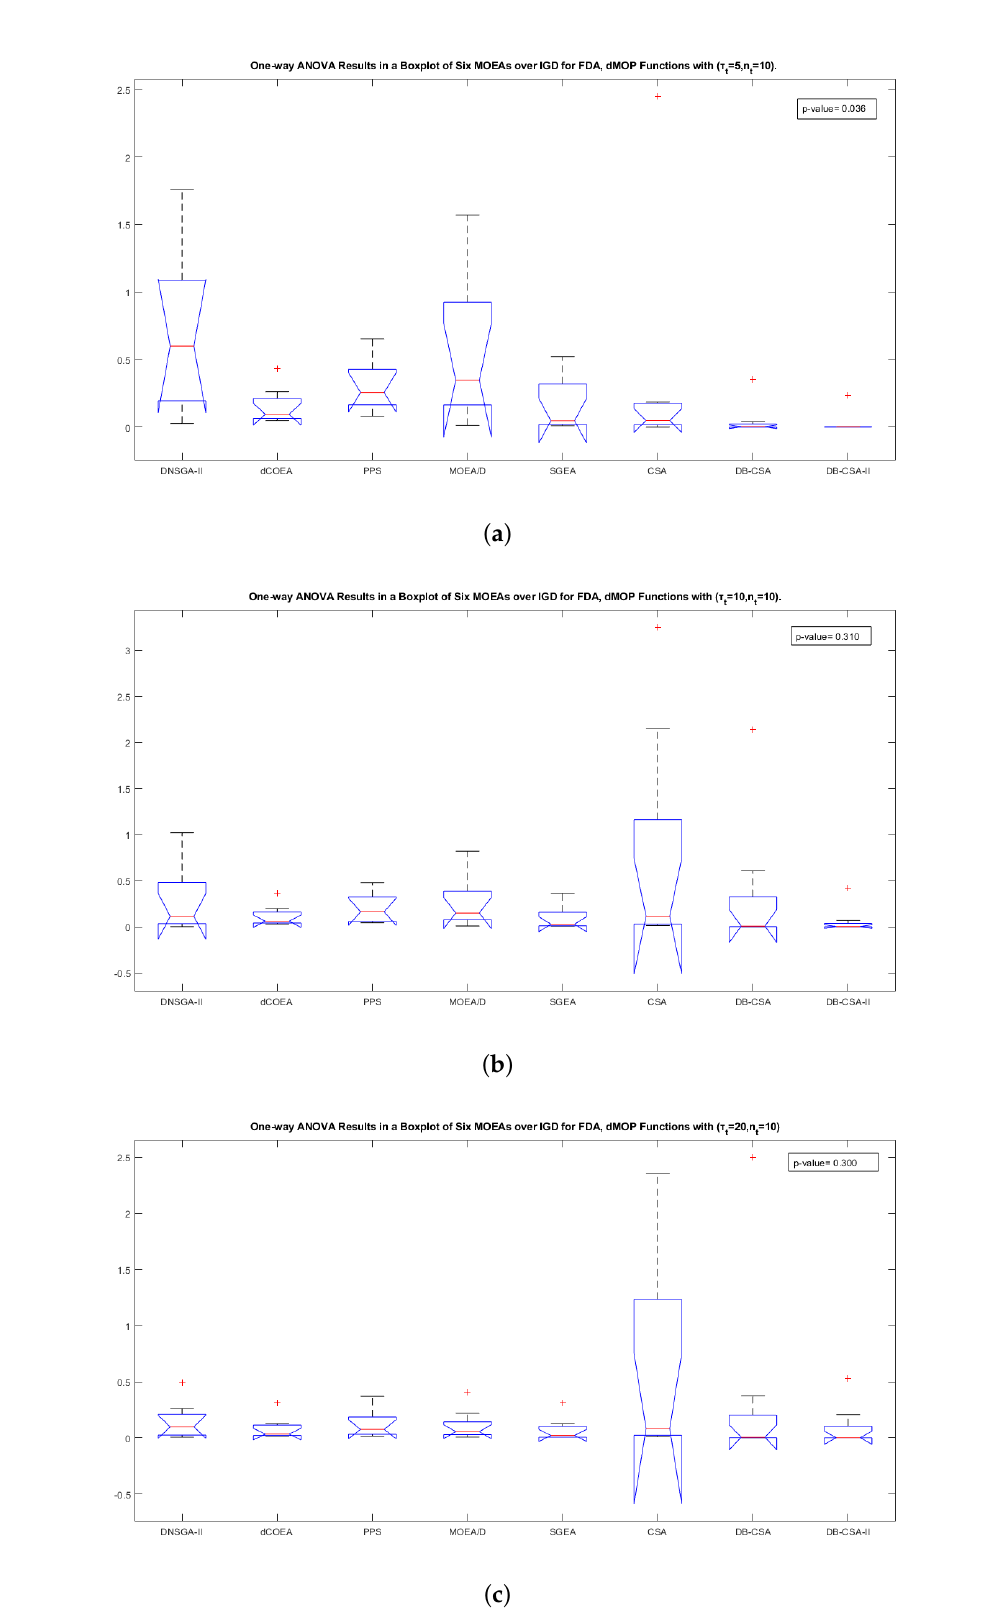
Figure 6. One-way ANOVA Box-plots of 6 MOEAs over IGD of FDA, dMOP for ( a ) severe with ( τ t = 5, n t = 10), ( b ) moderate ( τ t = 10, n t = 10), and ( c ) slight ( τ t = 20, n t = 10) environmental changes,